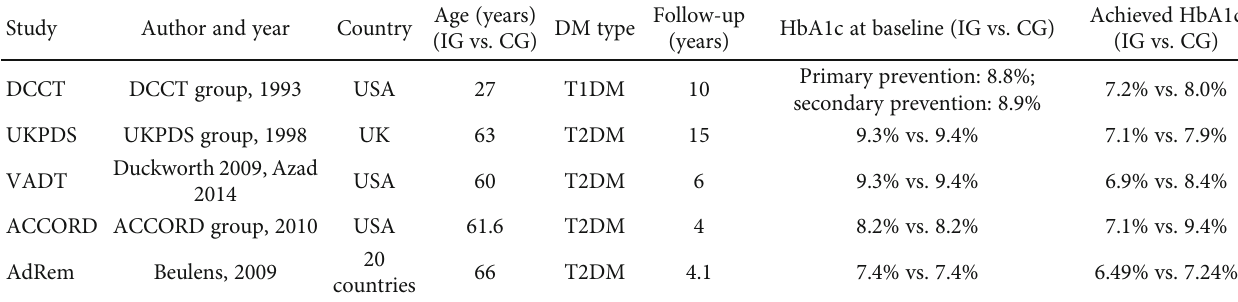
Table 1: Characteristics of included